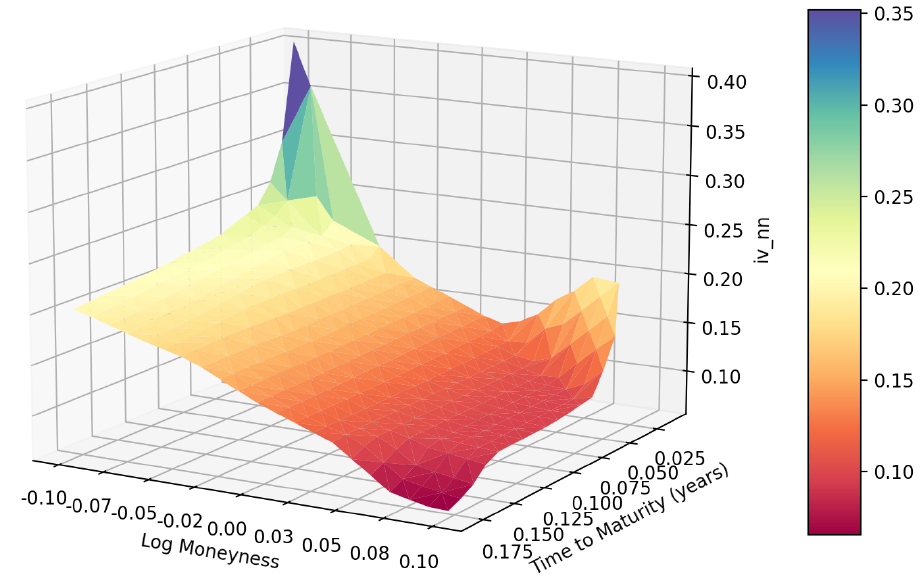
Figure 7. The rBergomi model’s IV surface inverted from S&P options data by